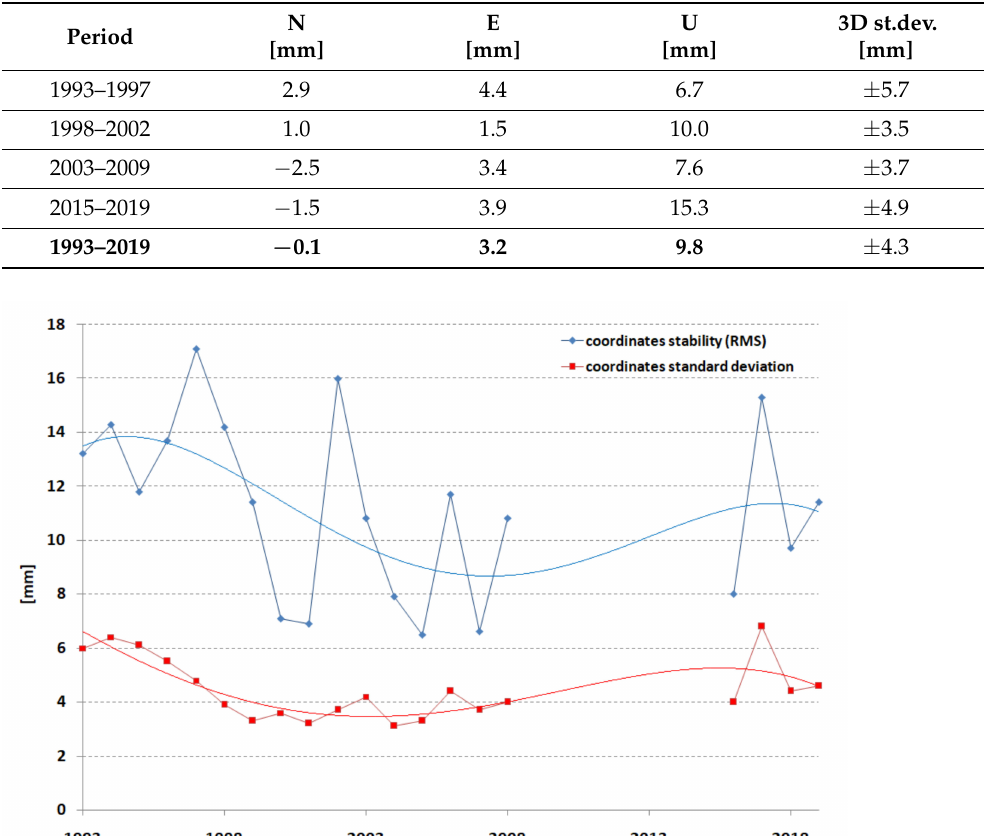
Table 6. Average topocentric coordinates N, E, U of Borowiec SLR station for each period after the ITRF2014 data conversion.